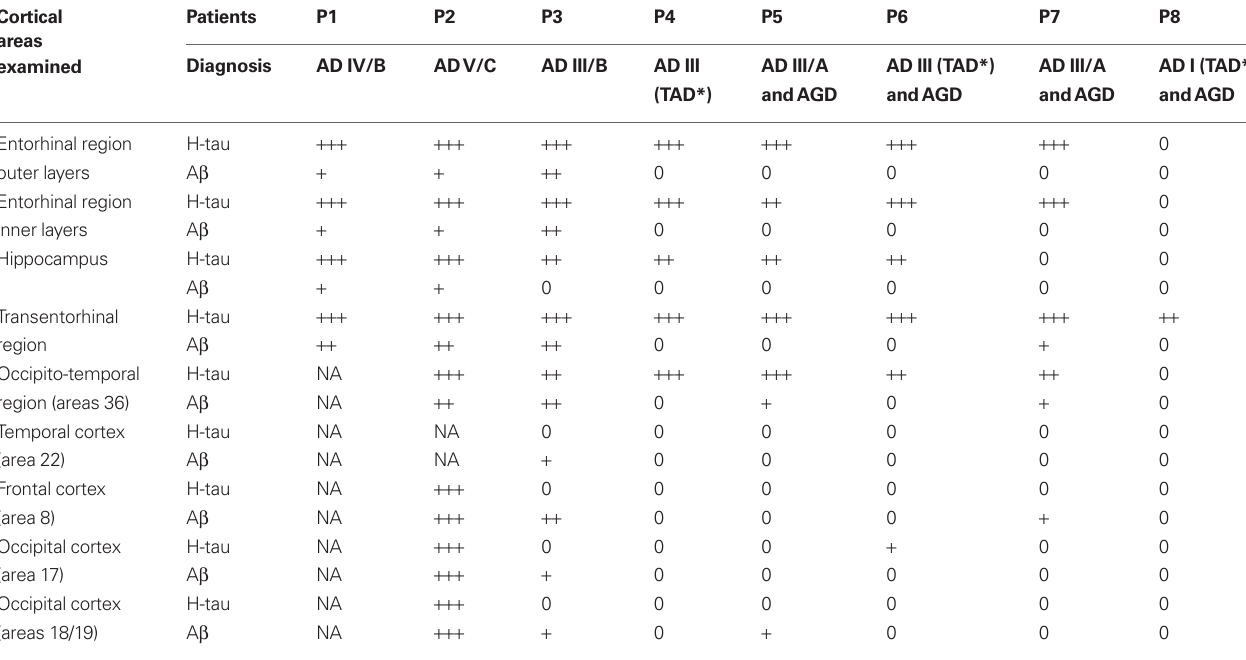
Table 2 | Neuropathological assessment for the accumulation of neurofi brillary tangles (immunostained for H-tau) and plaques (immunostained for amyloid- β : A β